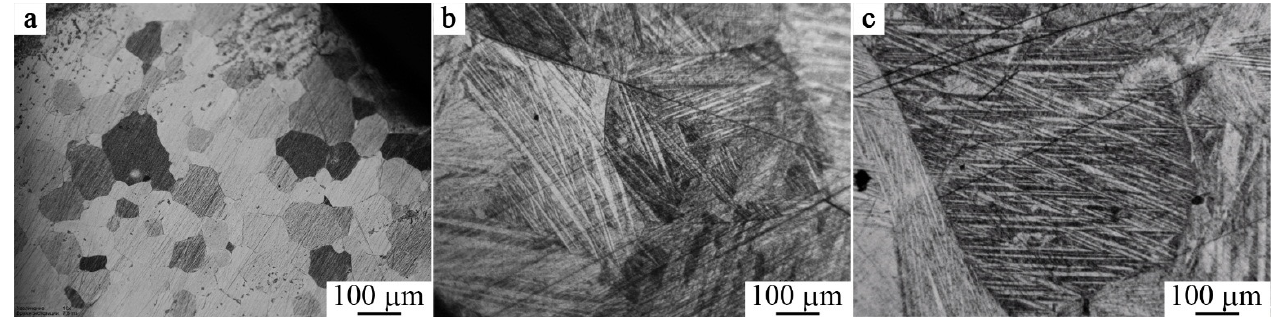
Figure 3. OM images of alloys ( a ) Cu-10Al-3Ni, ( b ) Cu-12Al-3Ni and ( c ) Cu-10Al-4.5Ni after quen- ching.